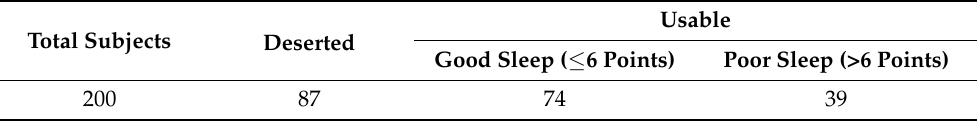
Table 3. Data information for sleep quality evaluation model. (Good and poor sleep are divided based on sleep questionnaires